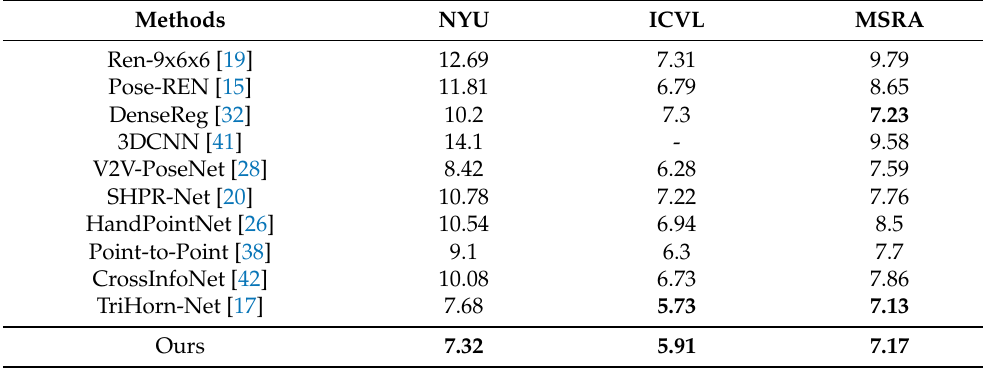
Table 2. Comparison with state-of-the-art methods on three public datasets: NYU, ICVL, MSRA.